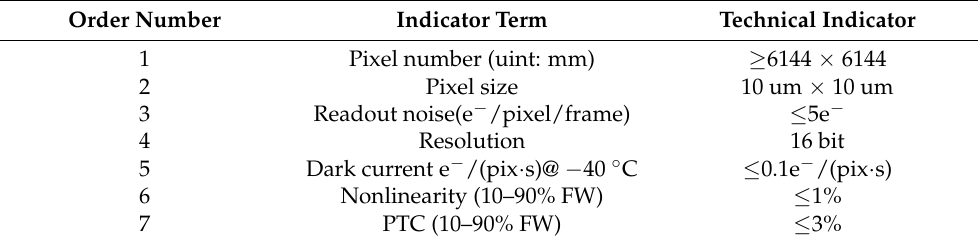
Table 1. Main technical indicators of the space